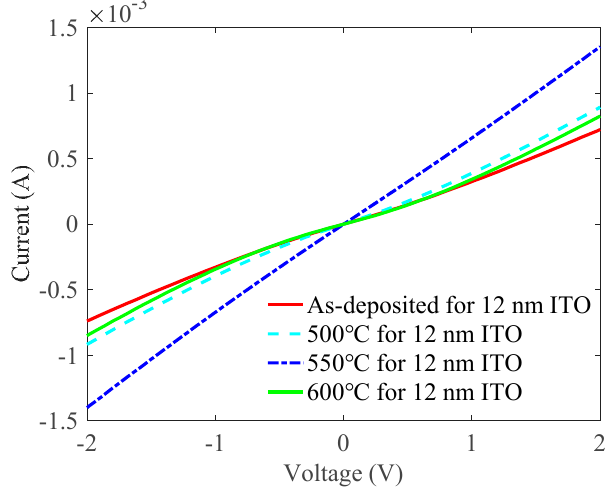
Figure 3. Current-voltage ( I - V ) characteristic curves of the multilayer with different annealing temperatures of the ITO contact layer when the thickness of the Ag metal layer was 17.5 nm and the annealing temperature of the whole ITO/Ga 2 O 3 /Ag/Ga 2 O 3 multilayer was 600 ◦ C. After determining the optimal thickness of the Ag metal layer and the annealing temperature of the ITO contact layer, we investigated the optimal thickness of the ITO contact layer. As shown in Table 2, a 6-nm-thick ITO, 12-nm-thick ITO, 18-nm-thick ITO, and 24-nm-thick ITO were first deposited on the quartz substrates and the LED epitaxial wafers, respectively. Then, all samples were annealed at 550 ◦ C for 1 min in N 2 /O 2 mixture ambient (N 2 :O 2 = 200:35 sccm). After that, we deposited a 15-nm-thick Ga 2 O 3 layer, a 17.5-nm-thick Ag metal layer, and another 15-nm-thick Ga 2 O 3 layer in sequence and annealed at 600 ◦ C for 1 min in N 2 /O 2 mixture ambient (N 2 :O 2 = 200:35 sccm). Figure 4a shows the transmittance spectra measured for the ITO/Ga 2 O 3 /Ag/Ga 2 O 3 multilayer on quartz substrates as a function of different thicknesses of the ITO contact layer. The decrease in transmittance with increasing ITO thickness is attributed to the absorption of light by ITO. The multilayers exhibited transmittances of 87.0%, 86.4%, 81.9%, and 81.3% at 335 nm for ITO thicknesses of 6 nm, 12 nm, 18 nm, and 24 nm, respectively. Figure 4b shows the I - V characteristic curves of ITO/Ga 2 O 3 /Ag/Ga 2 O 3 multilayer on LED epitaxial wafers as a function of different thicknesses of ITO contact layers. However, the multilayer with the ITO thickness of 6 nm exhibited insulating I - V characteristic. This is because the ITO